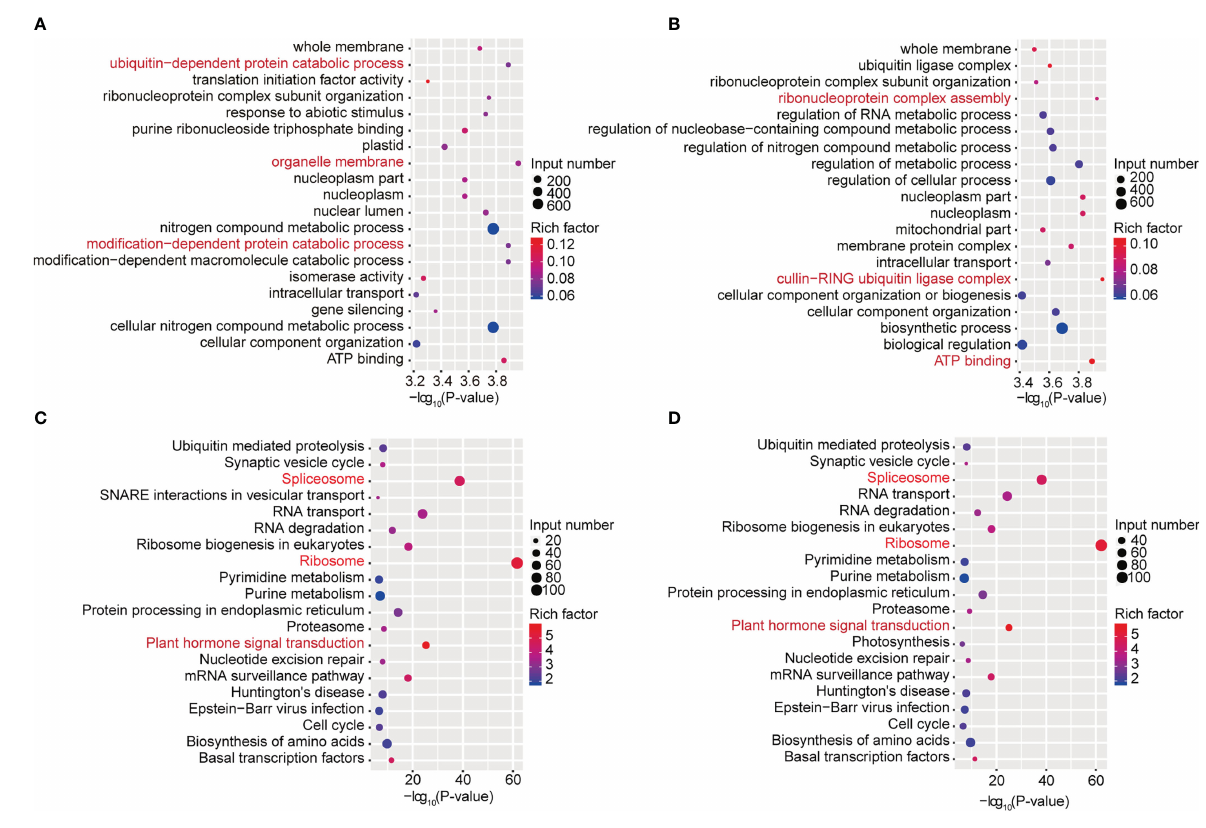
FIGURE 3 GO and KEGG pathway analyses of all methylated mRNAs. (A) The top 20 GO terms among genes modi fi ed by m 6 A in the dark. (B) The top 20 GO terms among genes modi fi ed by m 6 A under continuous white light. (C) The top 20 KEGG pathways among genes modi fi ed by m 6 A in the dark. (D) The top 20 KEGG pathways among genes modi fi ed by m 6 A under continuous white